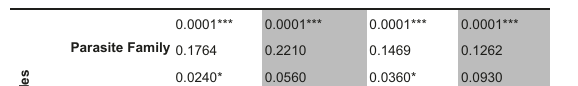
Results are provided for the full dataset (all sites at 0.01% threshold for Table 2. Univariate PERMANOVA analysis of parasite, bat, and bacterial relative abundance per sample), the strictly fi ltered dataset (all landscape in fl uences on microbiome variation. sites at 0.1% threshold for bacterial relative abundance), the samples collected from REGUA area sites (excluding southern sites), and the All Localities All Localities, Strictly Filtered REGUA Area REGUA Area Unprotected samples collected from fragments outside of REGUA (excluding southern sites). Grey shading indicates variables that signi fi cantly differentiated microbiomes and did not violate the assumptions of homoscedasticity. Univariate PERMANOVA results indicating the p value (top; * = p < 0.05,